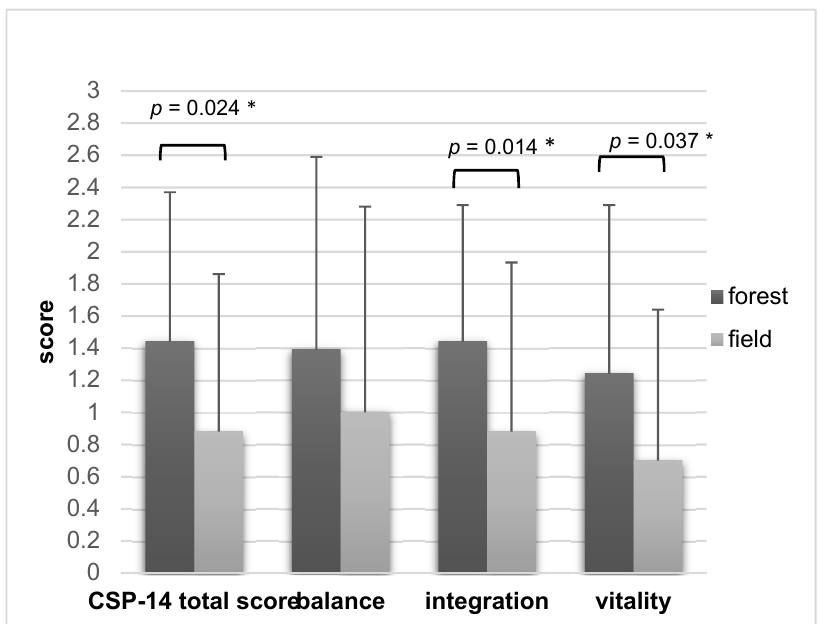
Figure 3. CSP-14 summer collective ( n = 23, mean values ± standard deviation), comparison of forest and field interventions. * = p < 0.05.